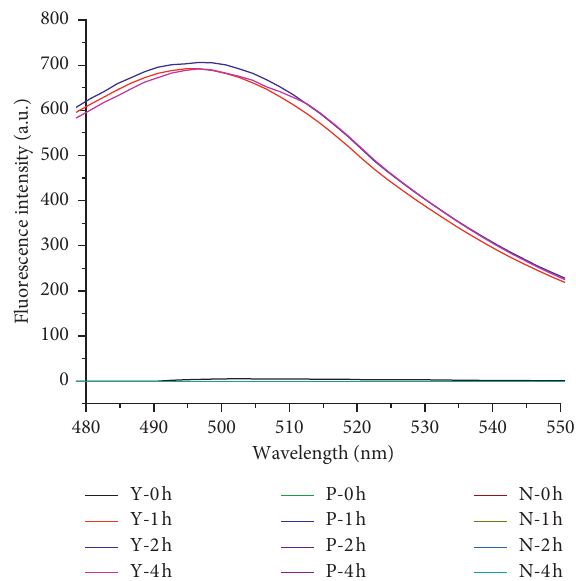
Figure 2: ThT spectroscopic profiles of nanofibers. Y: trypsin; P: papain; N: neutral protease.